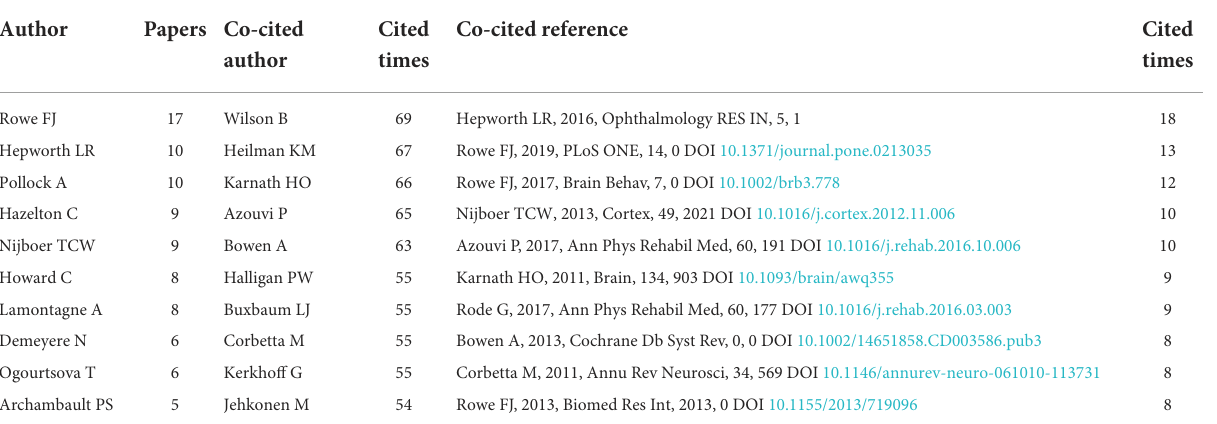
TABLE 2 The top 10 authors, co-cited authors, and co-cited